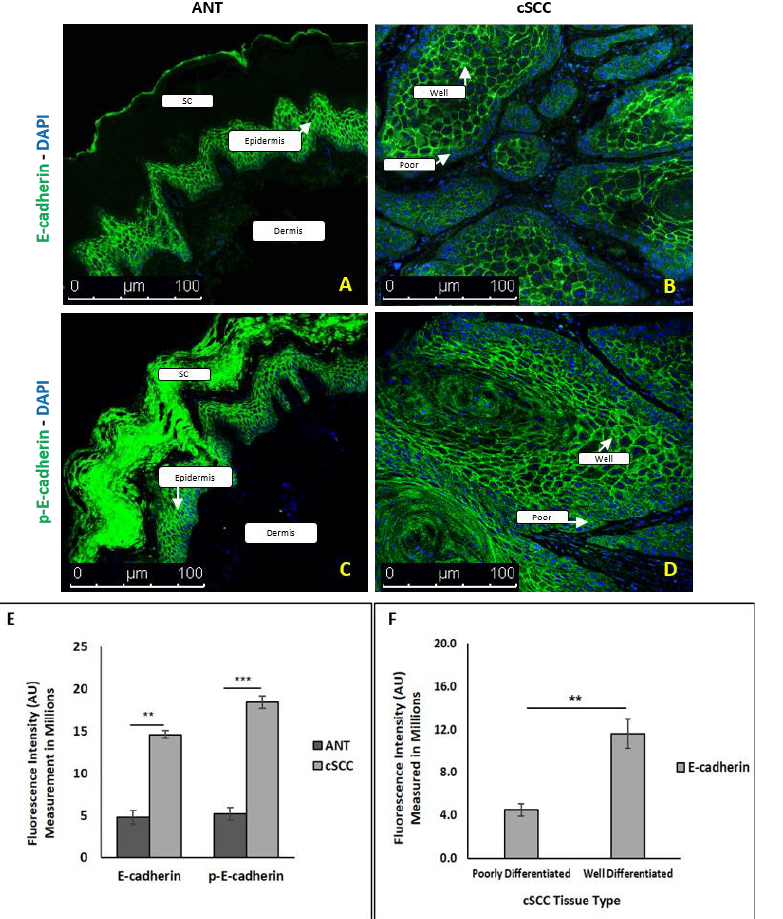
Figure 4. Immunofluorescence staining of ANT and cSCC tissues for E-cadherin (Panels A & B ) and phosphorylated E-cadherin (Panels C & D ); images were taken at 100× magnification. The epidermis and dermis layers of ANT are labeled, with the stratum corneum (sc) layer at the top. Quantitative analysis of protein expression between ANT and cSCC (Panel E ) and E-cadherin expression between well-differentiated tumor cells (well) in the center of the tumor mass vs. poorly differentiated tumor cells (poor) in the leading edge of the tumor (Panel F ) was performed. All values are expressed as mean ± SEM. ** denotes p < 0.005 and *** denotes p < 0.0001.